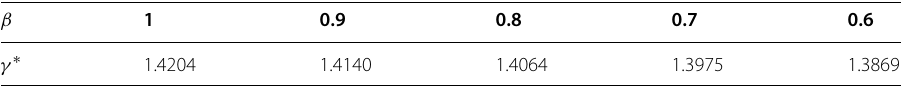
Table 2 Dissipative performance γ ∗ under different packet dropout rates β 1 0.9 γ ∗